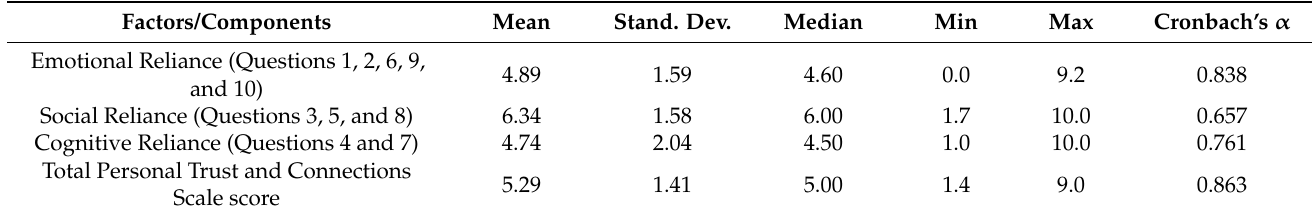
Table 3. Score levels and reliability of ‘Scale of Personal Trust and Connections, PerTC’.